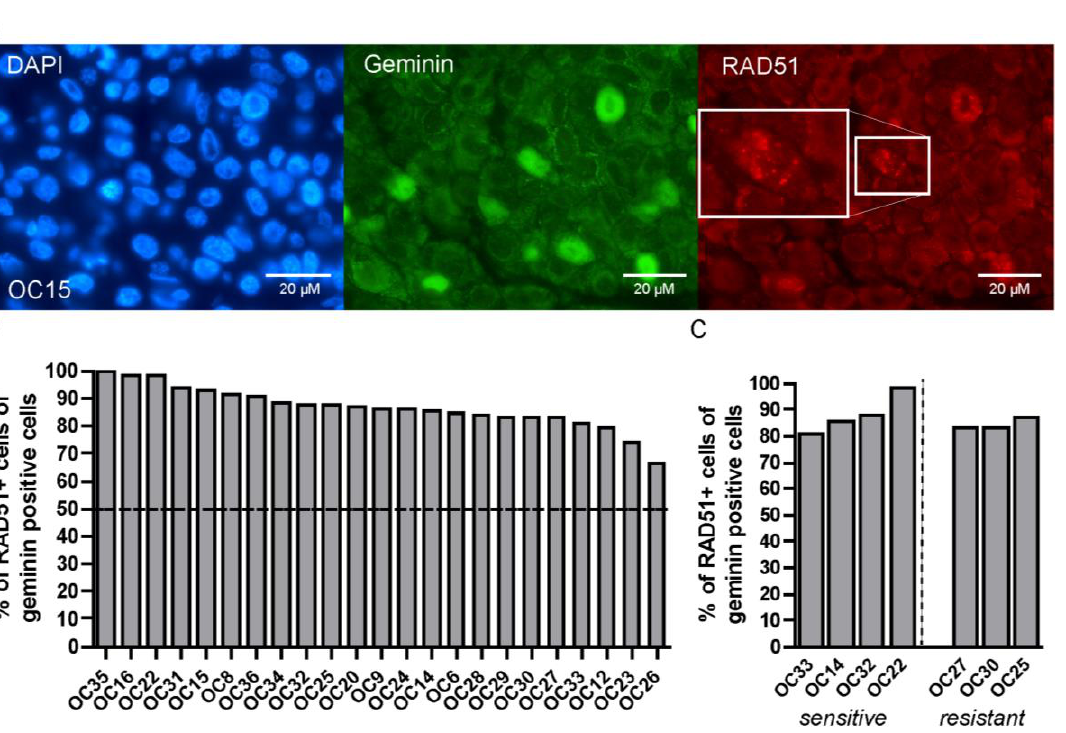
Figure 5. All tested HNSCC tumors form RAD51 foci 2 h after IR. ( A ) Representative microscopy